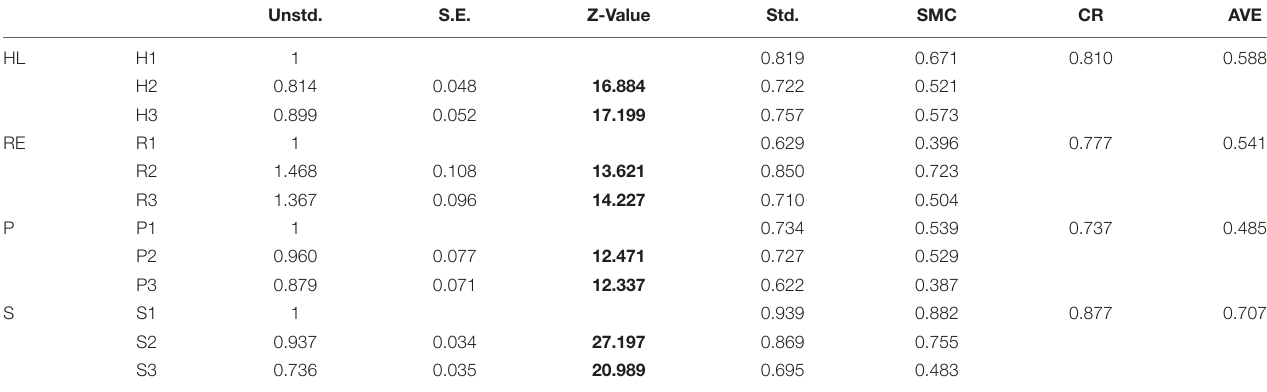
TABLE 2 | Measurement model.